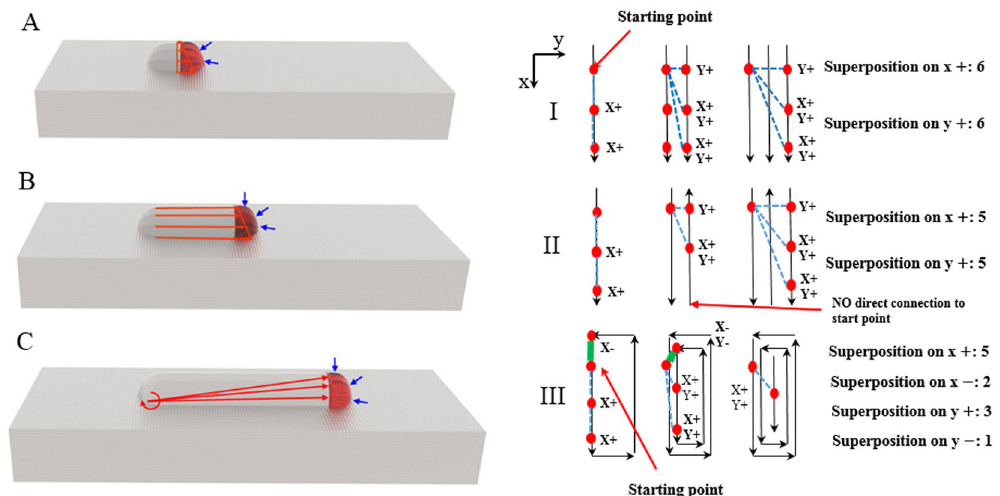
Figure 10. The stress superposition during the laser